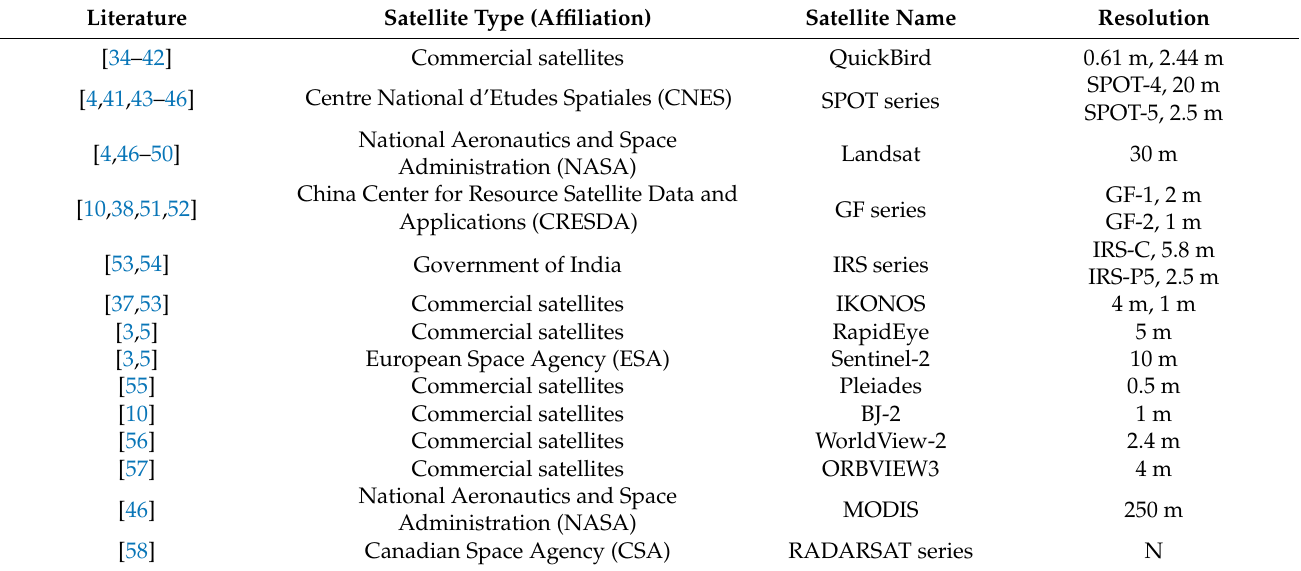
Table 1. Types, names, and resolutions of remote sensing satellites used in the literature.